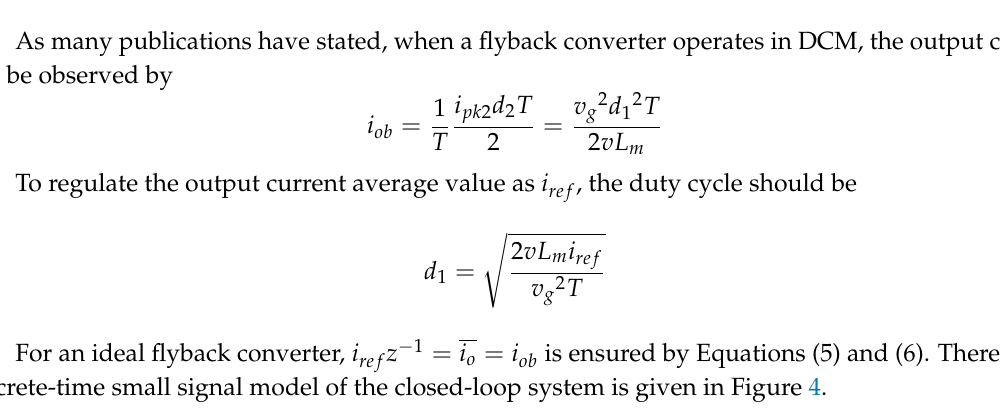
Figure 3. Flyback converter. ( a ) circuit scheme, ( b ) currents when operating in DCM.